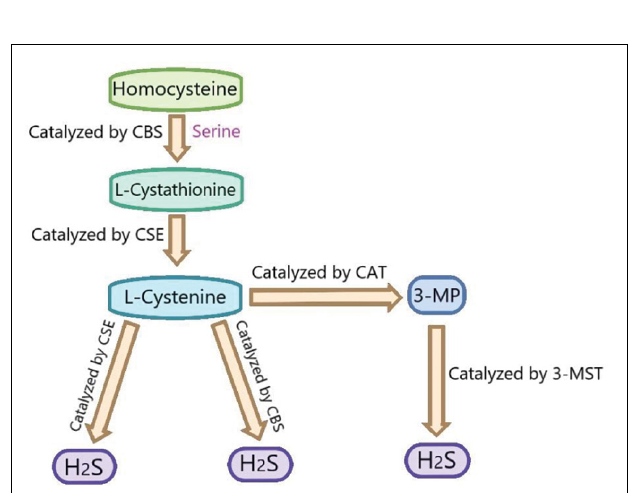
FIGURE 2 | The summary of the production of endogenous H 2 S. CBS, cystathionine-beta-synthase; CSE, cystathionine-gamma-lyase; 3-MST, 3-mercaptopyruvate thiotransferase; 3-MP, 3-mercaptopyruvate; CAT, cysteine aminotransferase.